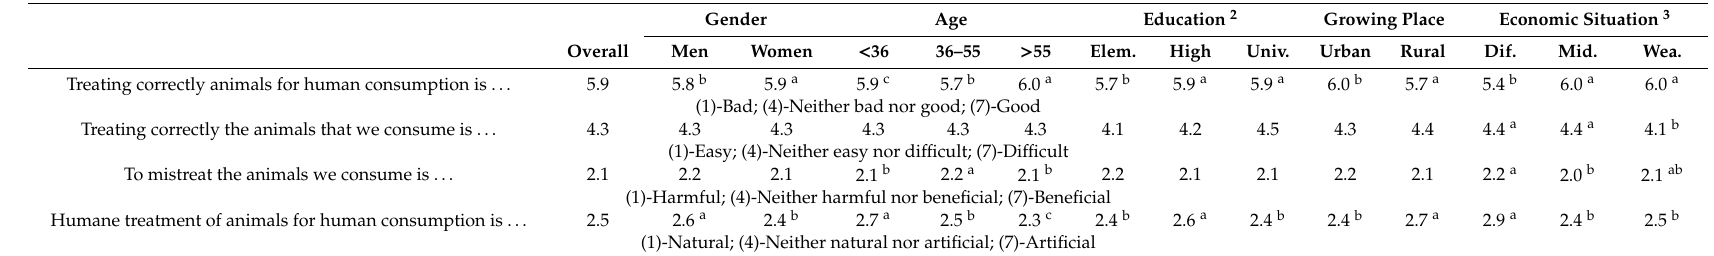
Table 4. The attitudes of Eastern European consumers towards castration and the e ff ect of demographics 1 . Gender Age Education 2 Growing Place Economic Situation 3 Overall Men Women < 36 36–55 > 55 Elem. High Univ. Urban Rural Dif. Mid. Wea.